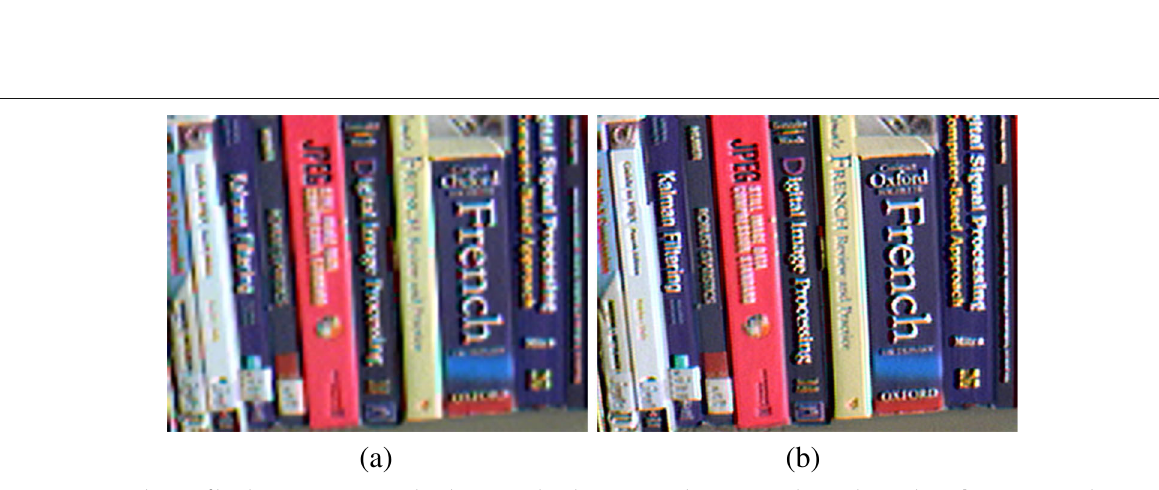
Fig. 7 Super-resolution of bookcase images. a One bicubic-interpolated LR image with an up-sampling scale equal to 4. b Reconstructed HR image by OSR with an up-sampling scale equal to 4